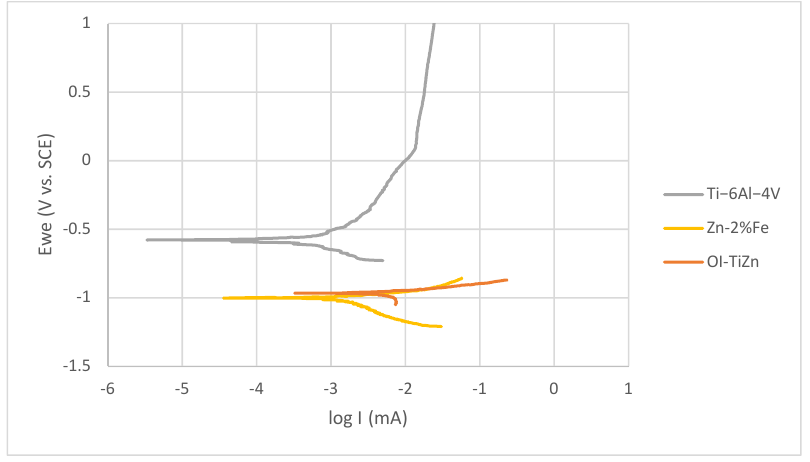
Figure 10. A magnified view of the galvanic corrosion attack in the vicinity of the Ti-base lattice after immersion test for 14 days.